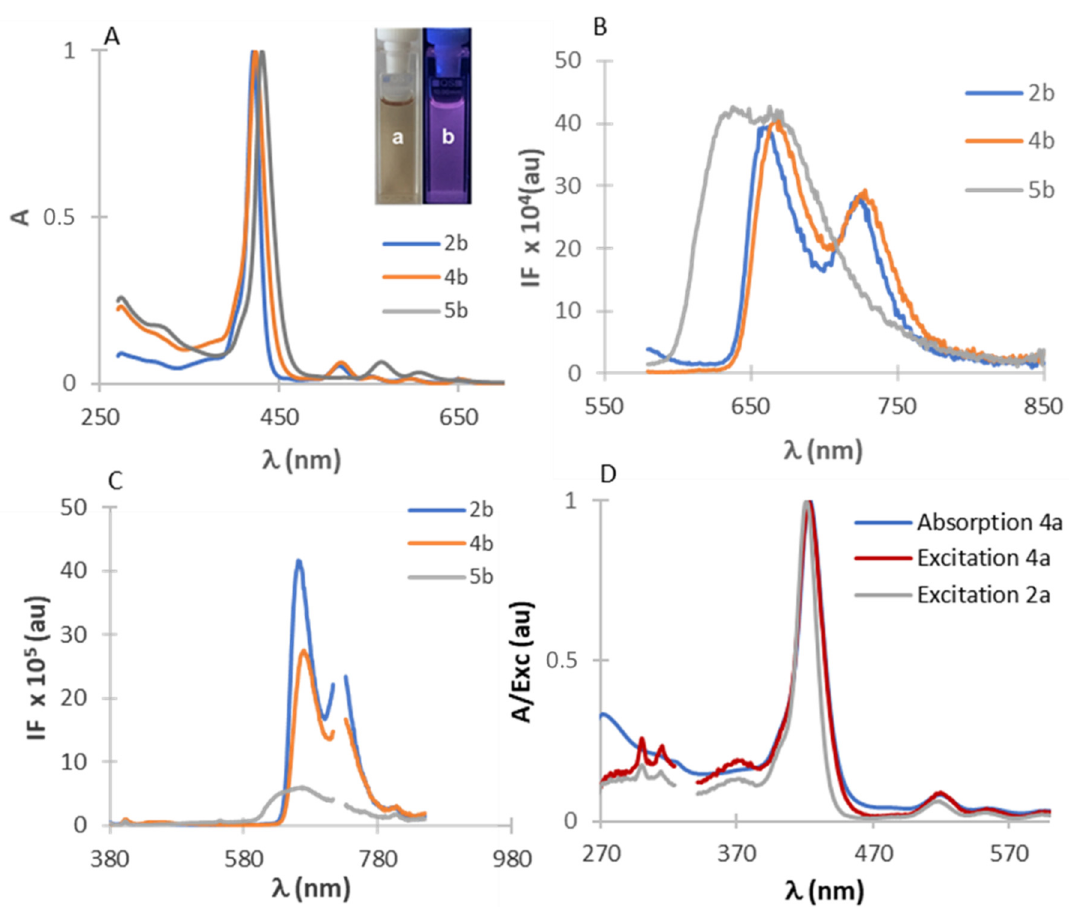
Figure 2. ( A ) UV-Vis absorption and ( B , C ) Fluorescence emission spectra of compounds 2b , 4b , and 5b in DMF at room temperature (non-degassed solutions) at a concentration of approximately 6 × 10 − 6 M and λ exc = 565 and 360 nm, respectively. ( D ) Absorption spectra of 4a and Excitation spectra of diluted solutions of 2a and 4a in DMF at room temperature, λ exc = 650 nm. Inset photographs a and b : solution of 4b in DMF, respectively, under visible light and after excited at 365 nm. Raw data spectrum 2C are shown in Supplementary Information (Figure